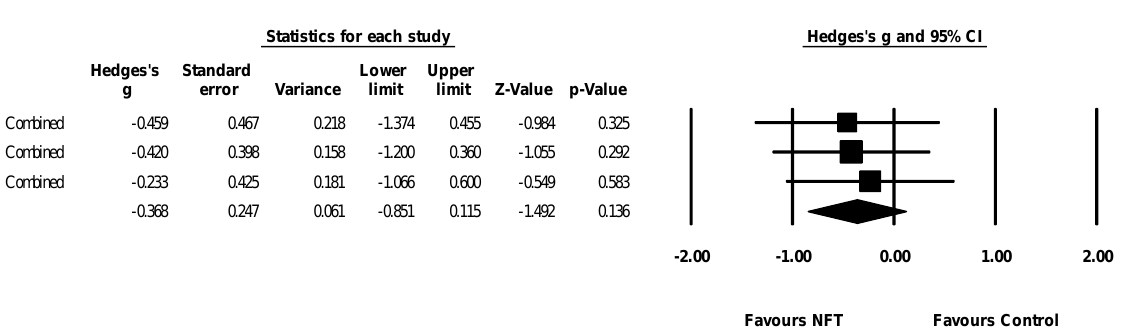
Figure 3. Forest plot of meta-analysis of fMRI-NFT on overall PTSD symptoms. Misaki et al (2018)